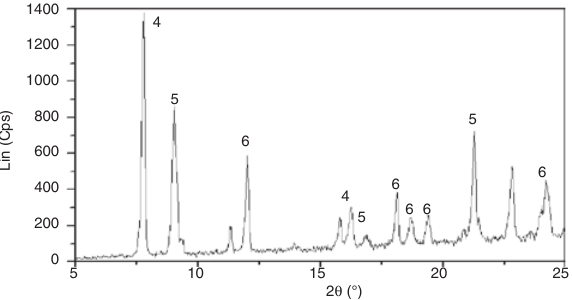
Figure 12: X-ray diffraction pattern of dehydrated Cu-BTC, formed from Cu and benzene-1,3,5-tricarboxylic acid, (4-C